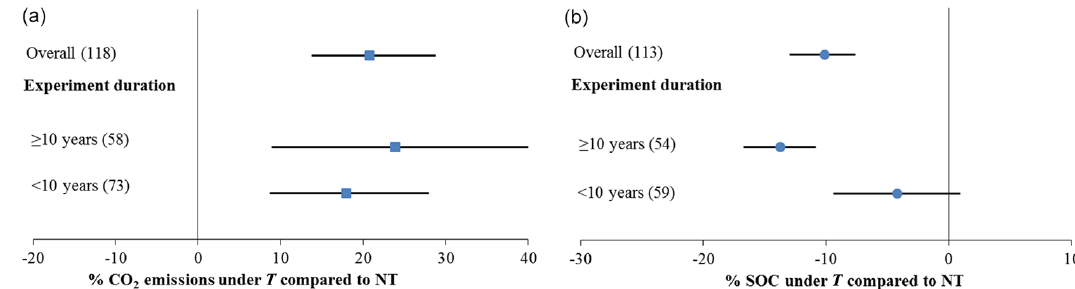
Figure 5. Percent change in (a) soil CO 2 emissions and (b) SOC in tillage ( T ) soil compared to no-tillage (NT) as a function of experiment duration (<10 years and ≥ 10 years). The numbers in the parentheses indicate the direct comparisons of the meta-analysis. Error bars are 95% confidence intervals.